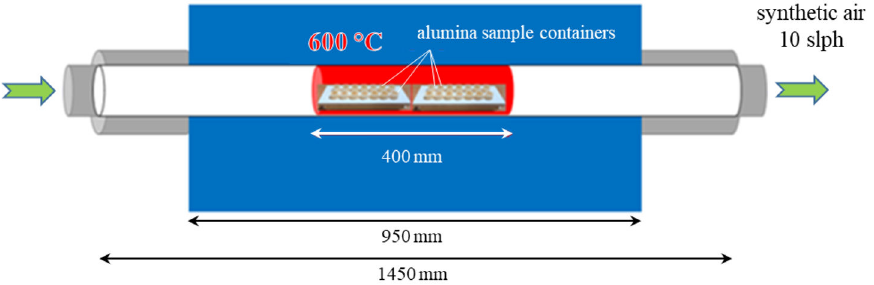
Figure 1. Schematic of the salt corrosion experimental set-up utilized at Forschungszentrum Jülich